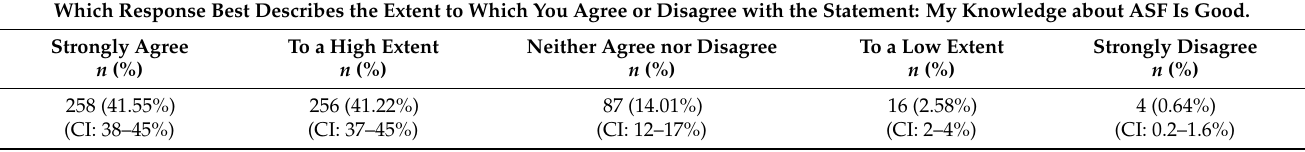
Table 1. Perception about the knowledge of ASF by Lithuanian hunters responding to the survey. Which Response Best Describes the Extent to Which You Agree or Disagree with the Statement: My Knowledge about ASF Is Good. Strongly Agree To a High Extent Neither Agree nor Disagree To a Low Extent Strongly Disagree n (%) n (%) n (%) n (%) n (%)